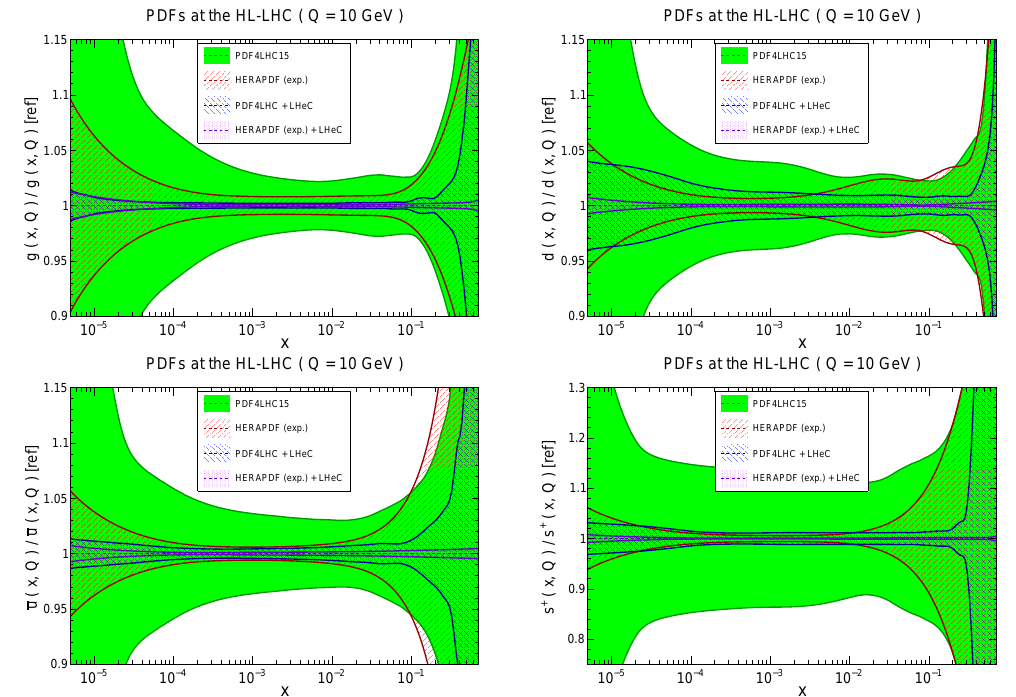
Figure 5.2: Same as Fig. 5.1, but with the error relative to each set